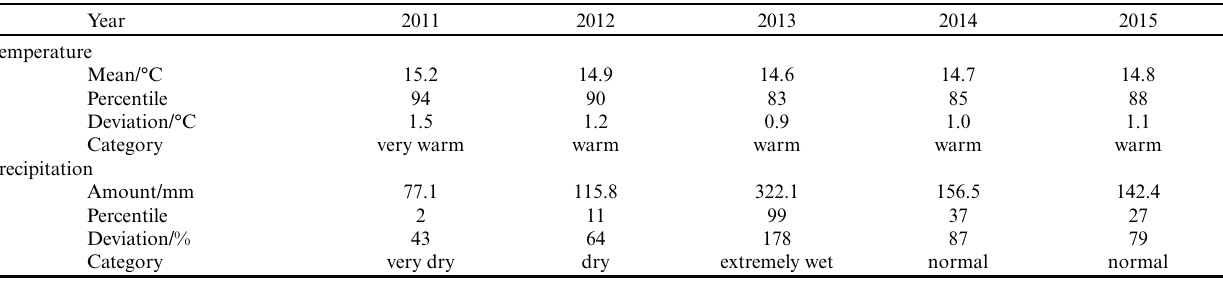
Table 1 . Mean spring (March–May) air temperature (°C) and spring precipitation amount (mm) in Šibenik, Croatia for years 2011– 2015, percentiles of multiannual mean for the period 1961–1990, deviation from mean spring air temperature (in °C), and precipitation amount (in percentage) compared to multiannual mean for the period 1961–1990, climate assessment categories according to percentile criterion (extremely cold/dry < 2, very cold/dry 2–9, cold/dry 9–25, normal 25–75, warm/wet 75–91, very warm/wet 91–98, extremely warm/wet > 98; Juras